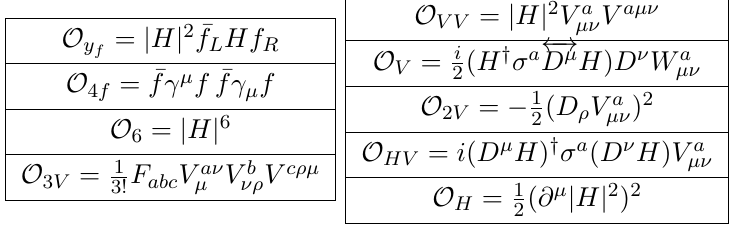
Table 2 . The operators under consideration, where 3 V =3 W; 3 G ; V V = BB; GG ; V = B; W ; 2 V =2 B; 2 W; 2 G ; HV = HB; HW . Moreover, a; b; c = 1 ; : : : ; 8; 1 ; : : : ; 3; ? , for SU(3) ; SU(2) L ; U(1) Y , respectively, with F abc = f abc ; (cid:15) abc ; 1 the corresponding structure